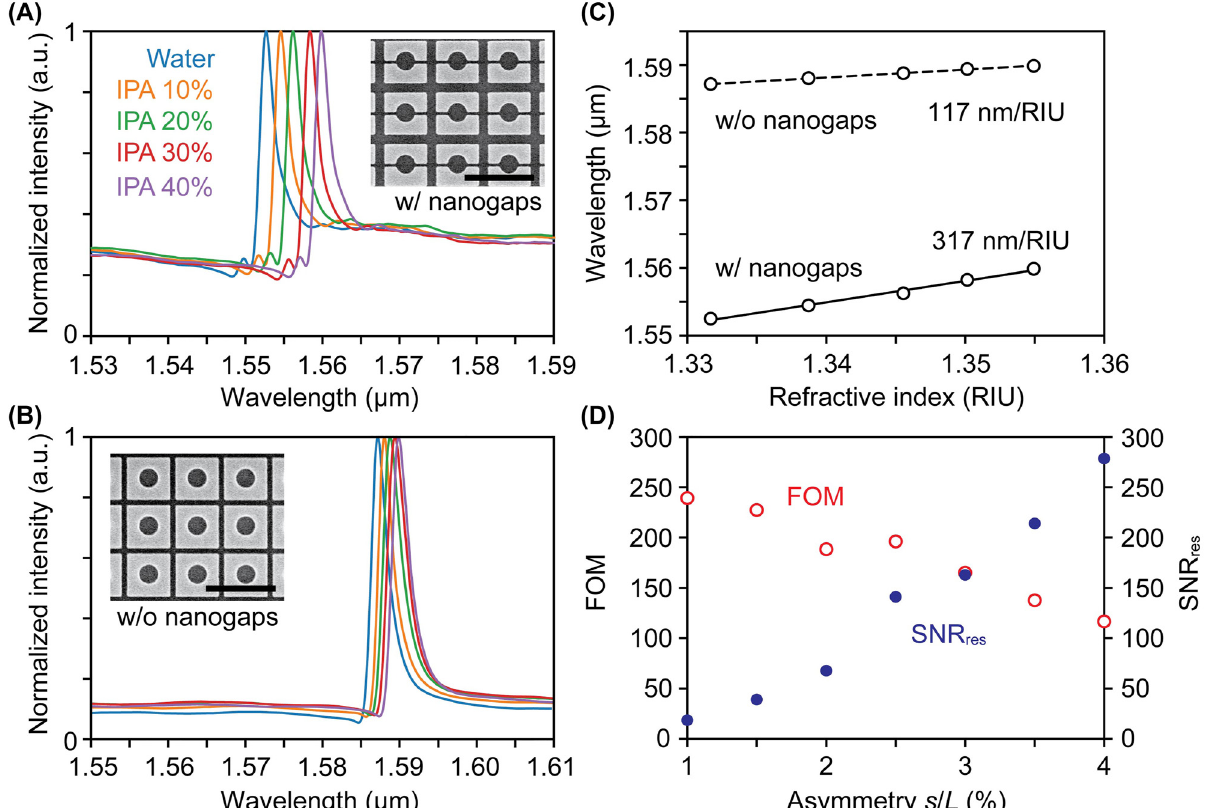
Figure 6: Measurement results of the refractive index sensitivity. (A), (B) Normalized reflectance spectra measured in different concentrations of IPA for the metasurfaces ( s / L = 2%) with and without nanogaps, respectively. Insets show the SEM images with the scale bars of 1 μ m. (C) Resonance peak shift of the metasurfaces with (solid line) and without (dashed line) nanogaps as a function of the bulk refractive index. (D) FOM (red open circles) and (blue closed circles) with different asymmetries s / L for the metasurfaces with SNR res